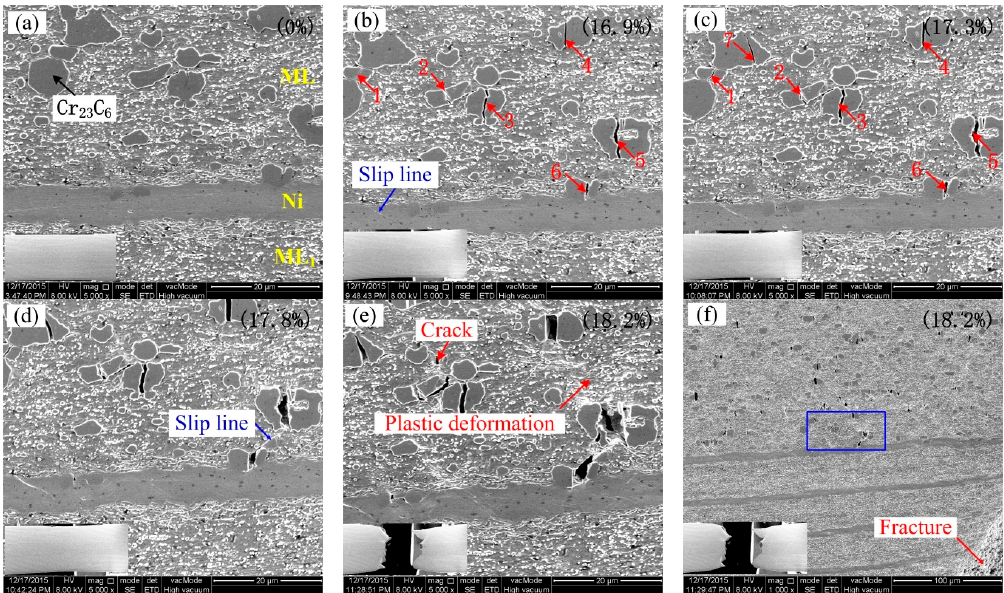
Figure 8. SEM features and cracking of carbides observed at various tensile elongations, ( a ) 0, ( b ) 16.9%, ( c ) 17.3%, ( d ) 17.8%, ( e , f ) 18.2%.